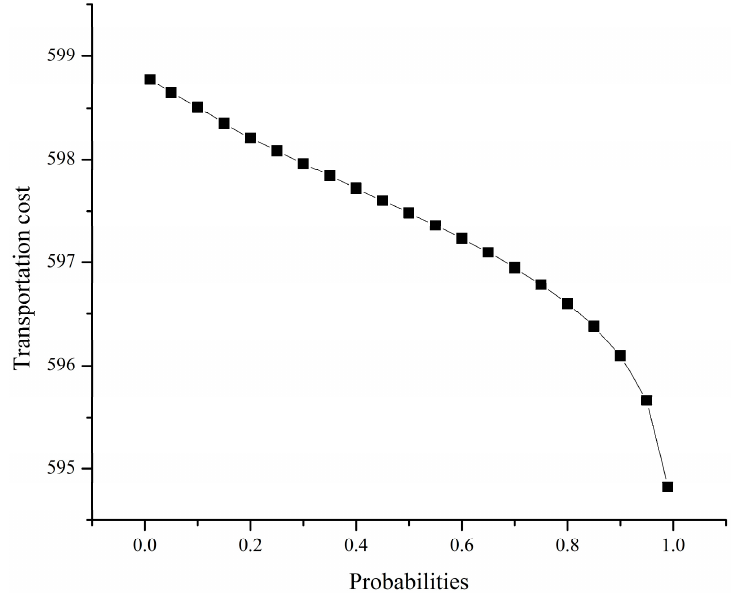
Table 9. Sensitivity analysis with respect to the probability for 𝑒 (cid:3038) . Figure 4. Sensitivity analysis of the optimal transportation cost concerning the probability for conveyance capacities.